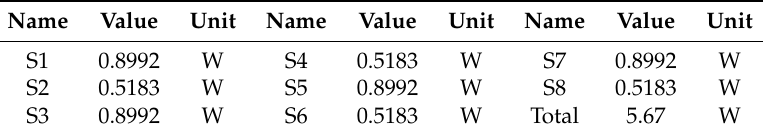
Table 2. Heat source power for